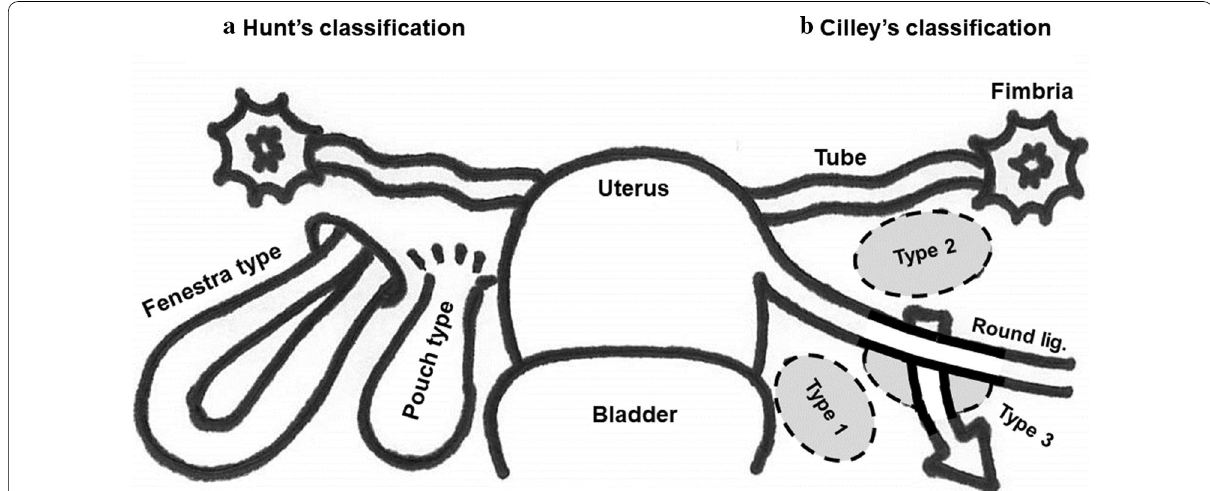
Fig. 4 Two classifications of broad ligament hernia. Hunt’s classification divides the disease into fenestra and pouch types on the basis of the nature of the hernia defects ( a ). Cilley’s classification is anatomically based: in type 1, the defect develops caudal to the round ligament of the uterus; in type 2, the defect is located above the round ligament between the mesovarium and the mesosalpinx; and in type 3, the defect occurs in the mesoligamentum teres of the uterus ( b ). Dotted ovals represent openings and an arrow indicates the route of herniation in type